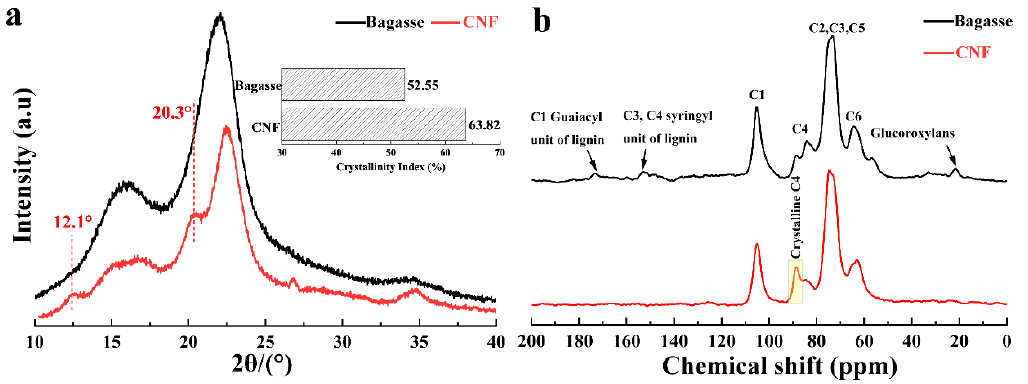
Figure 7. ( a ) X-ray diffraction (XRD) patterns of the bagasse and CNFs. ( b ) 13 C cross-polarization magic angle spinning ( 13 C CPMAS) nuclear magnetic resonance (NMR) spectra of the bagasse fiber and CNFs.